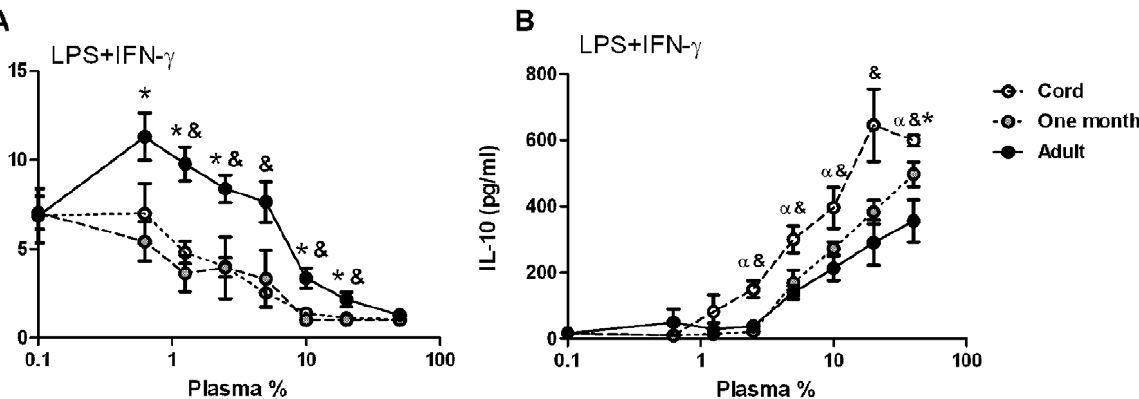
Figure 2. Suppression of TLR4-mediated IL-12p70, but not induction of IL-10, by neonatal plasma is maintained up until the age of one month. Adult PBMC were stimulated with LPS (100 ng/mL) and IFN- c (20 ng/mL) in the presence of plasma derived from cord blood, healthy newborns aged one month, or adult volunteers. After 24 h incubation, supernatants were collected and concentrations of IL-12p70 (A) and IL-10 (B) were determined by ELISA. Bars represent mean + SEM of three to five different plasma samples. a ; p , 0.05 cord blood vs neonatal plasma, *; p , 0.05 neonatal vs adult plasma, &; p , 0.05 cord blood vs adult plasma.